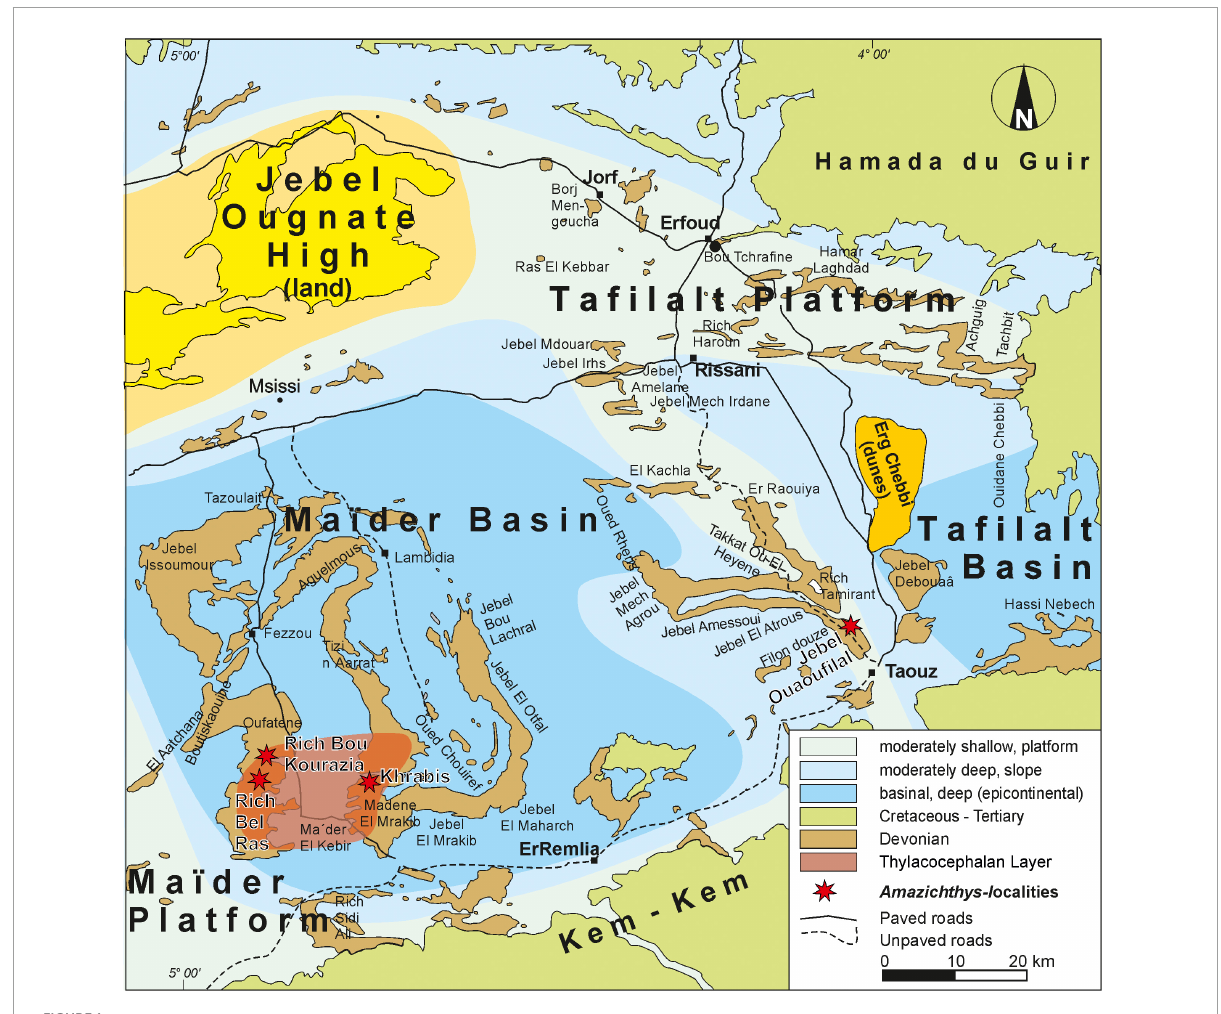
FIGURE1 Map of the Anti-Atlas with the localities where Amazichthys trinajsticae gen. et sp. nov. specimens were